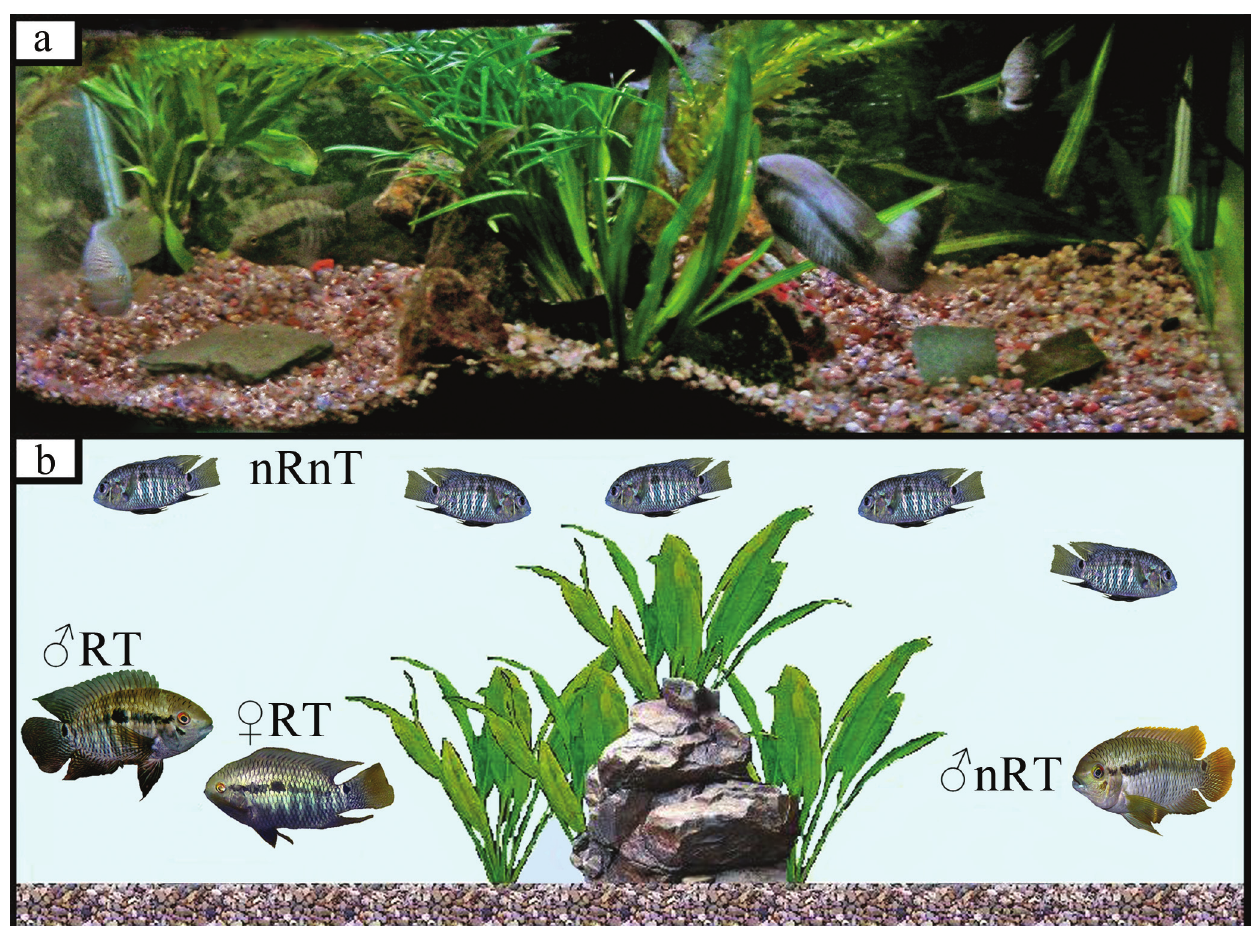
Fig. 1. Distribution of different social status fish on the experimental aquaria: a ) Picture of the experimental aquaria; b ) Schematic representation. Abbreviations of social statuses used: nRnT = non Reproductive non Territorial individuals; nRT = non Reproductive Territorial individual; RT = Reproductive Territorial individual. For a detailed description of these social statuses see Table